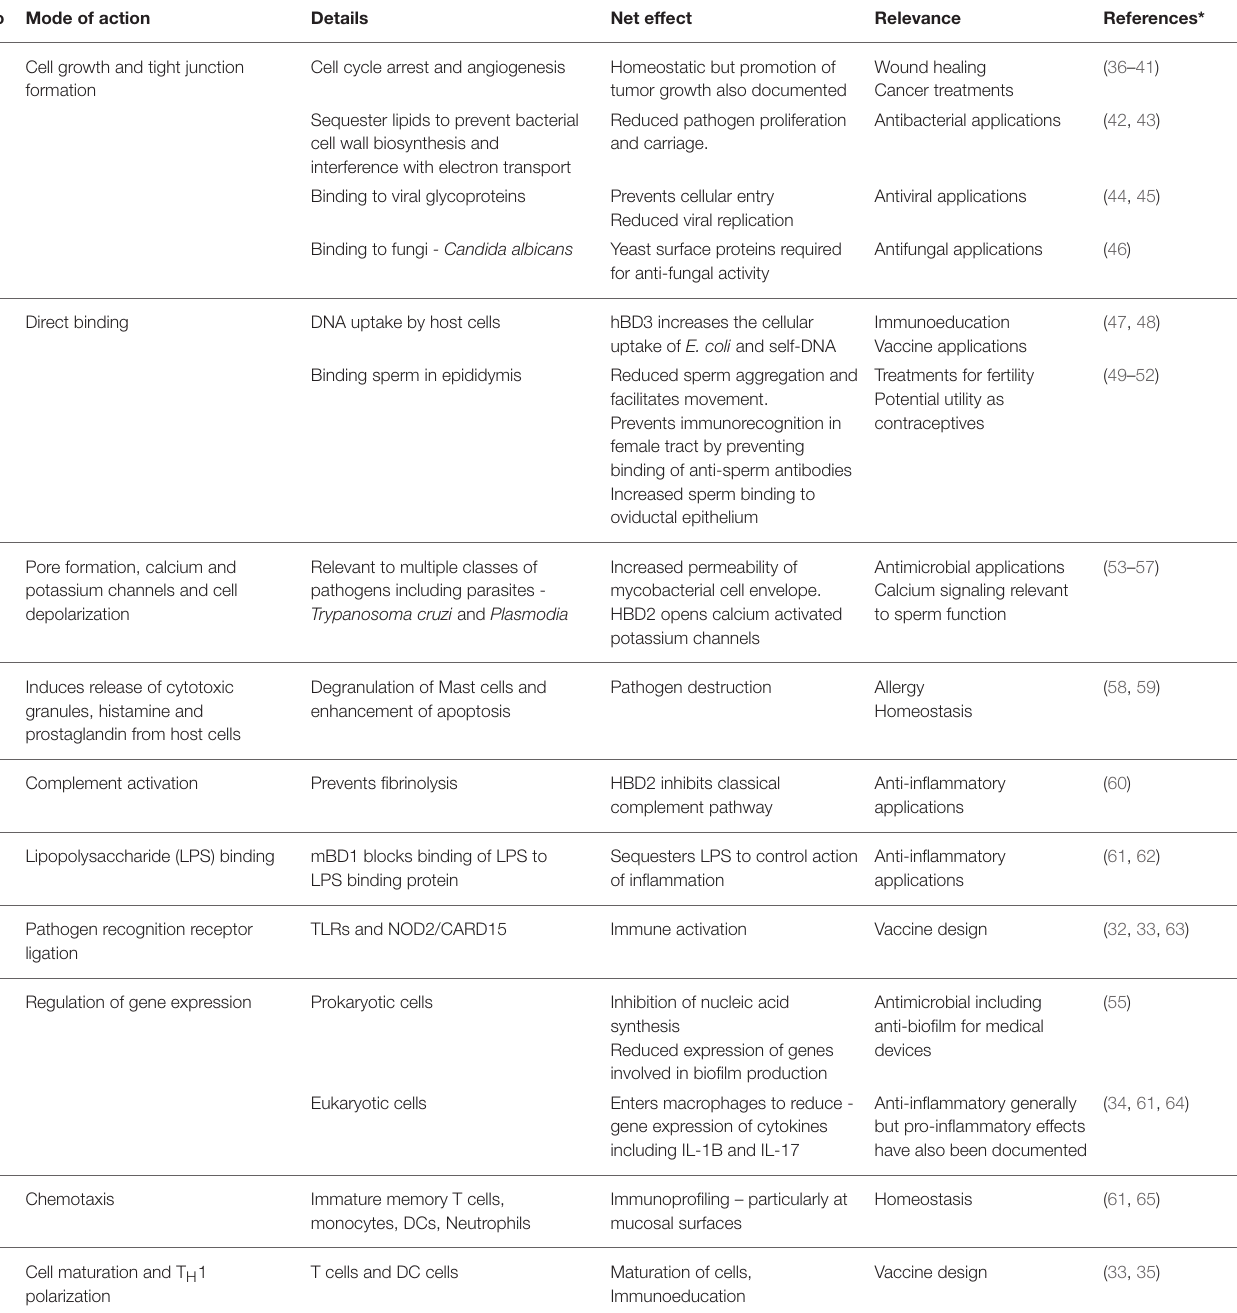
TABLE 1 | Catalog of distinct effector mechanisms documented for β -defensin host defense